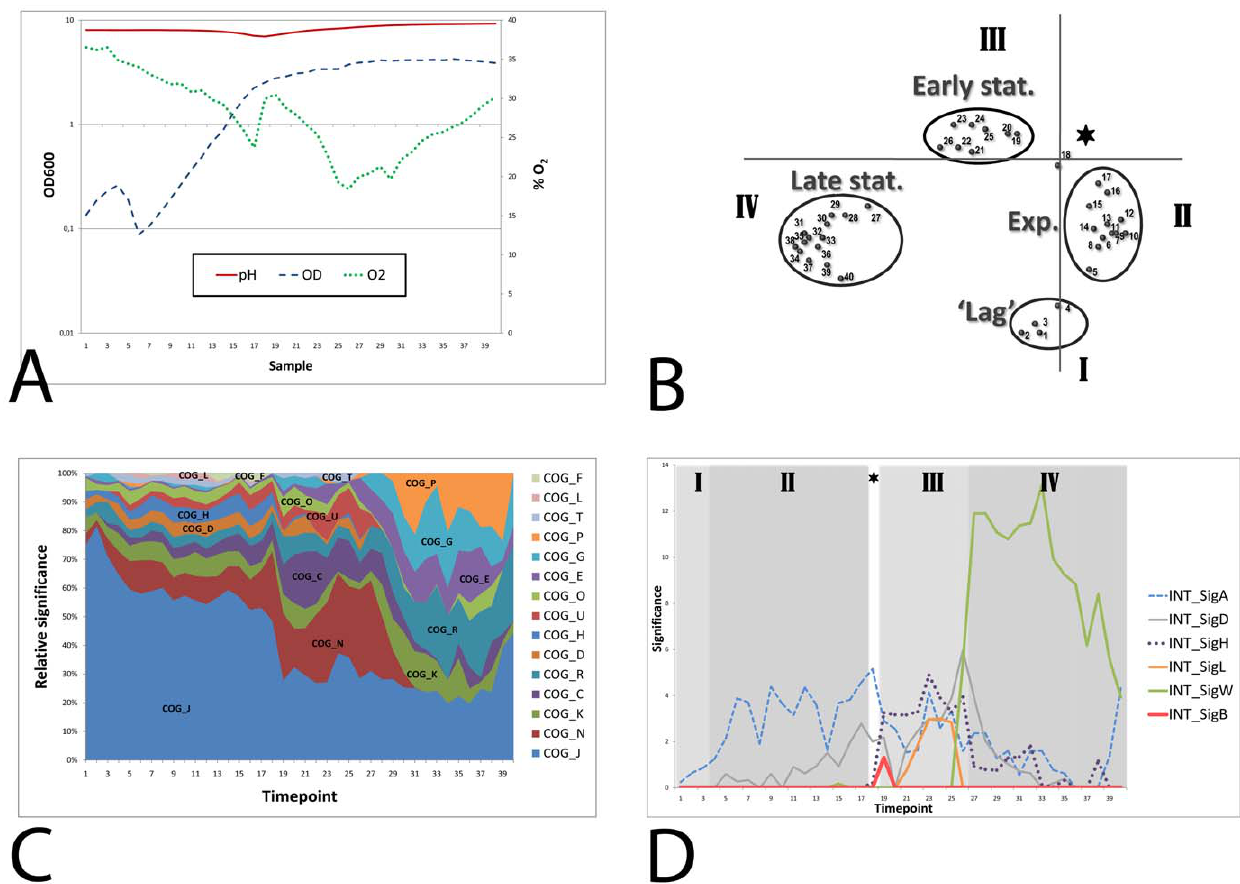
Figure 1. Growth curve and general characterization of the time-series experiment. A) Optical density (OD 600 ), pH and oxygen levels (% O2) of the culture were monitored. B) Visualization of the first two components from the PCA analysis. I: lag phase, II: exponential growth phase, III: early stationary phase, IV: late stationary phase. The asterisk represents the transition point. C) Significantly overrepresented COG classes (log transformed p-values (a´ =0.05 and Bonferroni corrected)) scaled per time point. COG_J: Translation, ribosomal structure and biogenesis, COG_K: